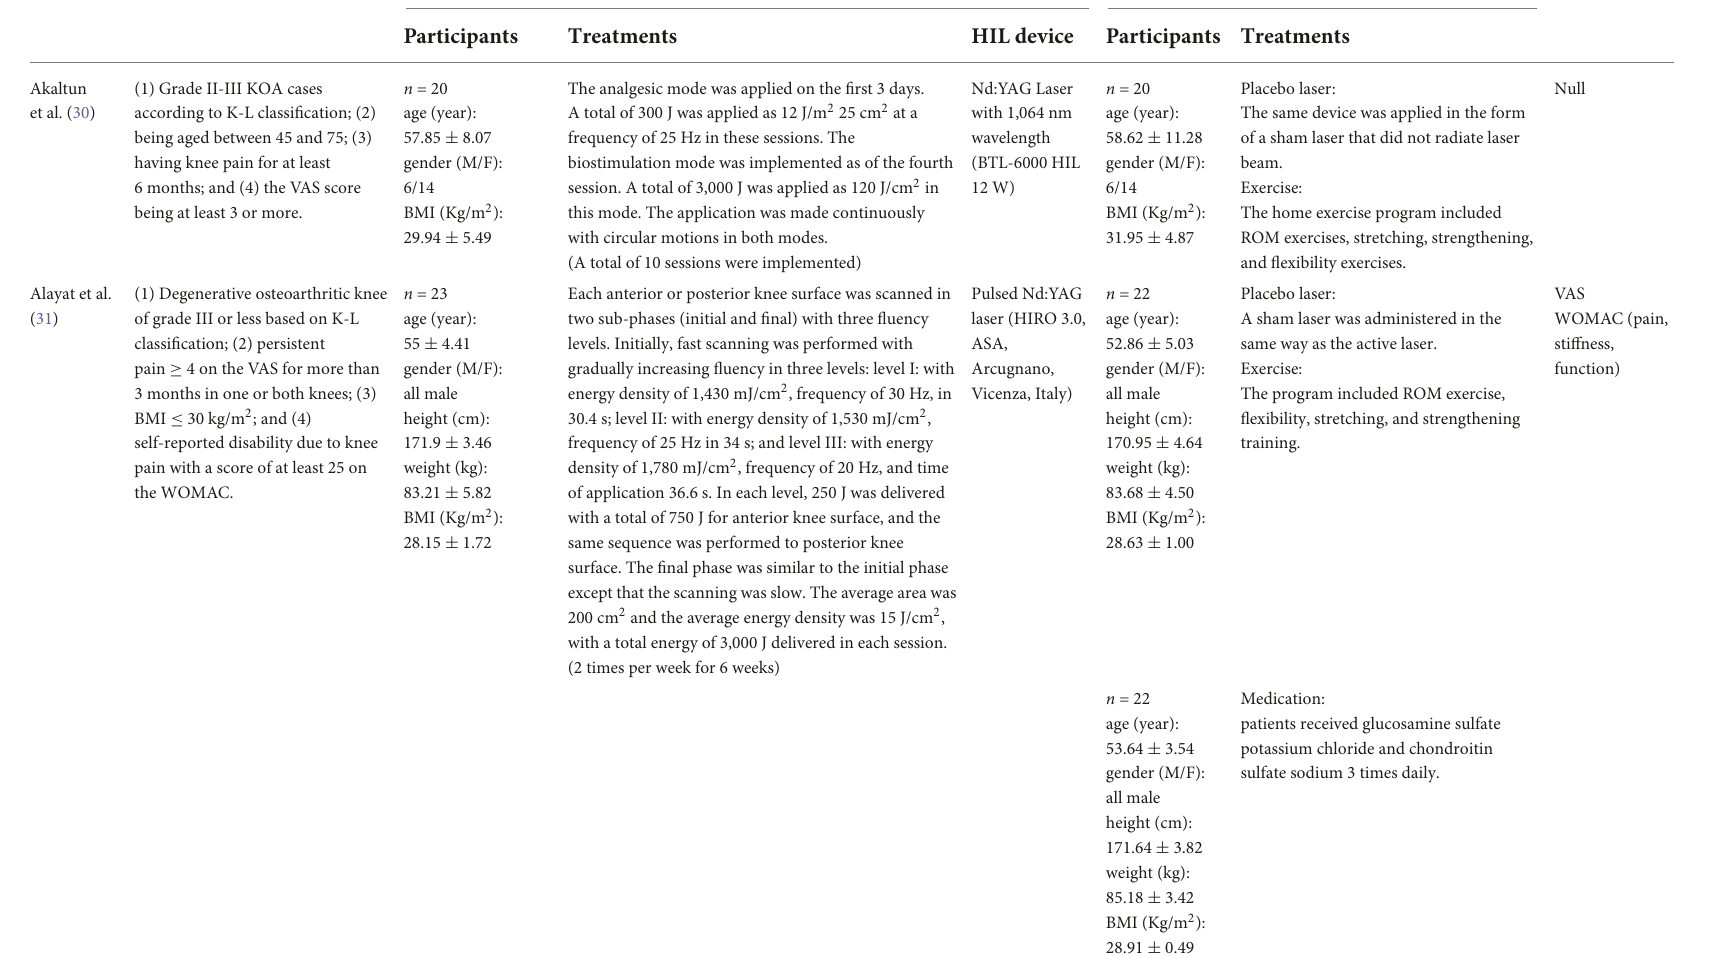
TABLE 2 Characteristics of included